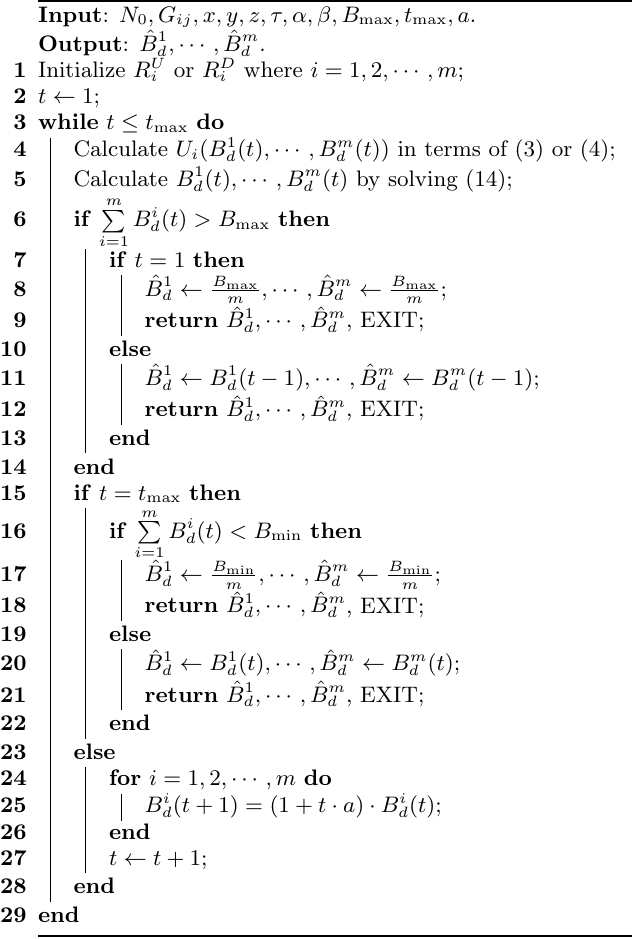
Algorithm 1: Resource Allocation